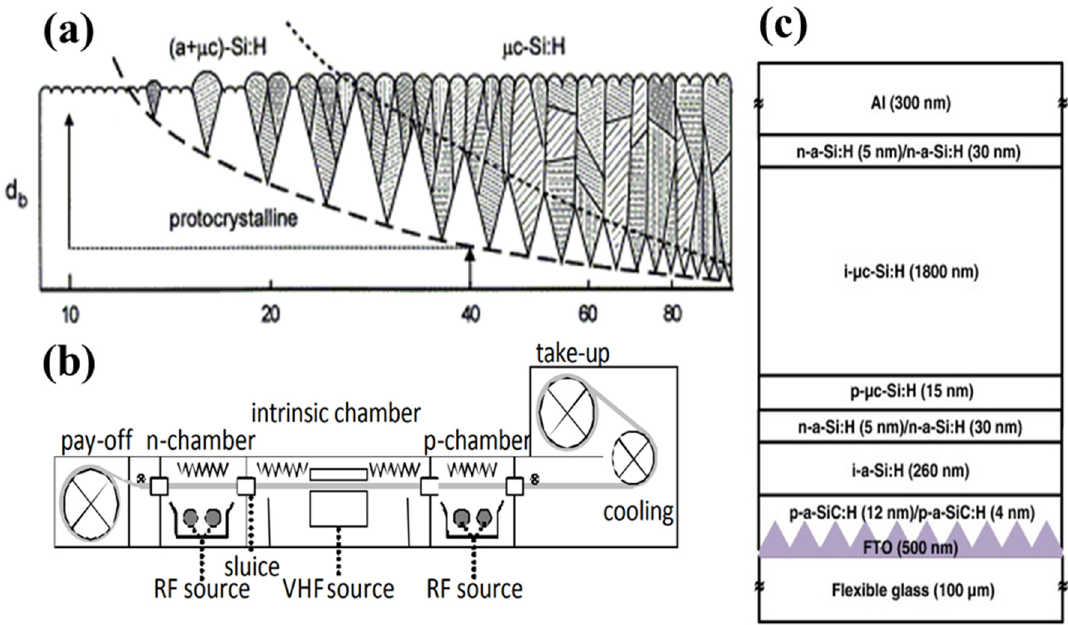
Figure 18. ( a ) Schematic of the structure of Si:H films prepared as a function of R . Reprinted with permission from ref. [81]. Copyright 2013 Elsevier; ( b ) cross section of the Flexicoat300 roll-to-roll PECVD system. Reprinted with permission from ref. [87]. Copyright 2010 EU PVSEC; ( c ) schematic cross-section of a PECVD-fabricated flexible a-Si:H/ μ c-Si:H double-junction solar cell with p-i-n configuration. Reprinted with permission from ref. [91]. Copyright 2014 Elsevier.